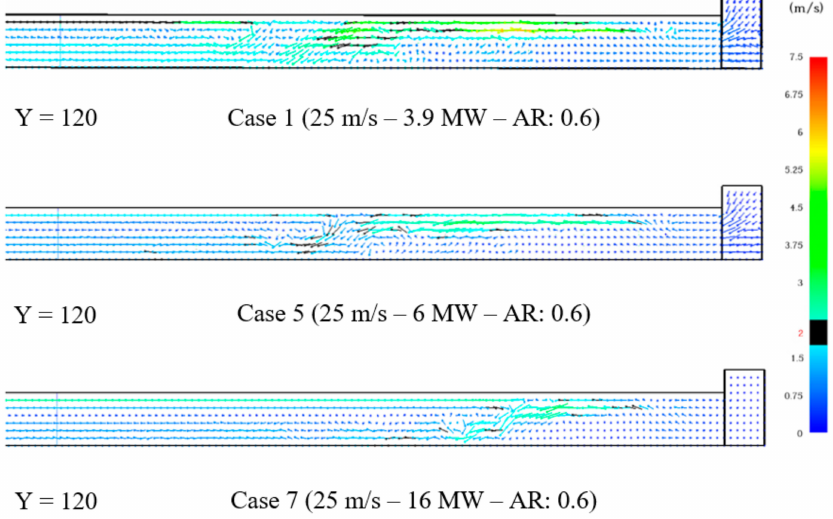
Figure 9. Velocity vector in the tunnel fire when changing the